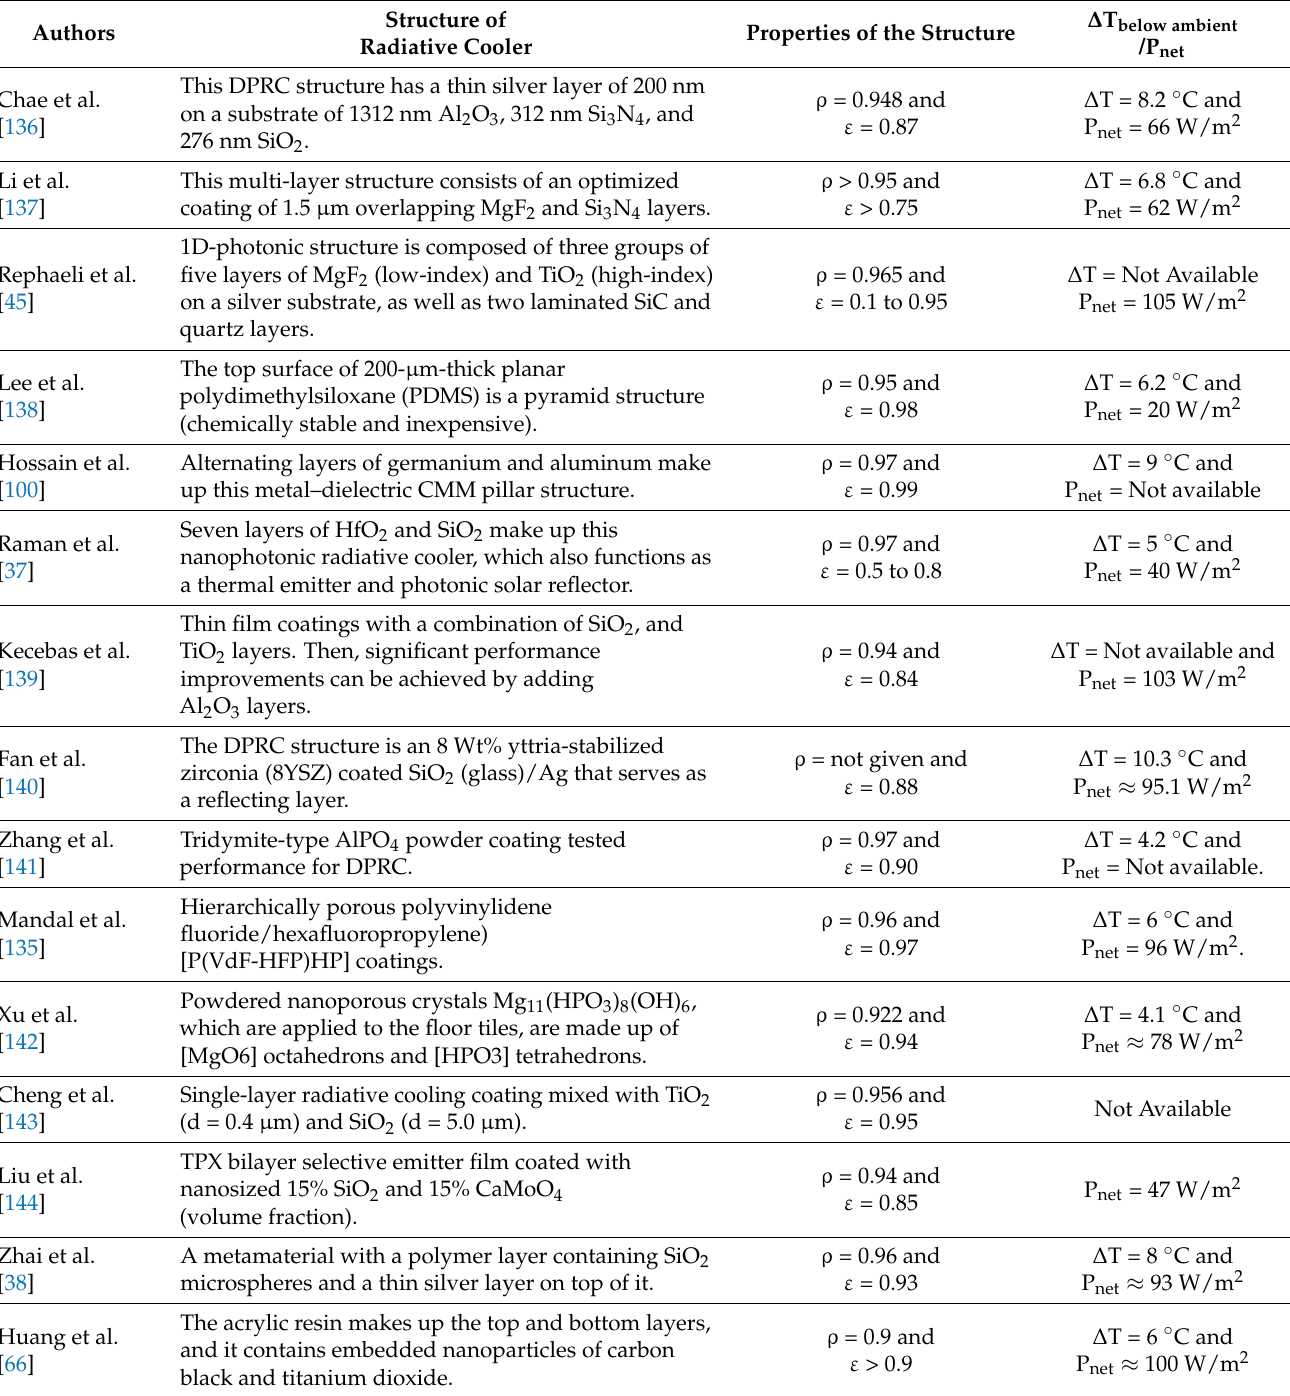
Table 2. An overview of the material composition, structures, and characteristics of a